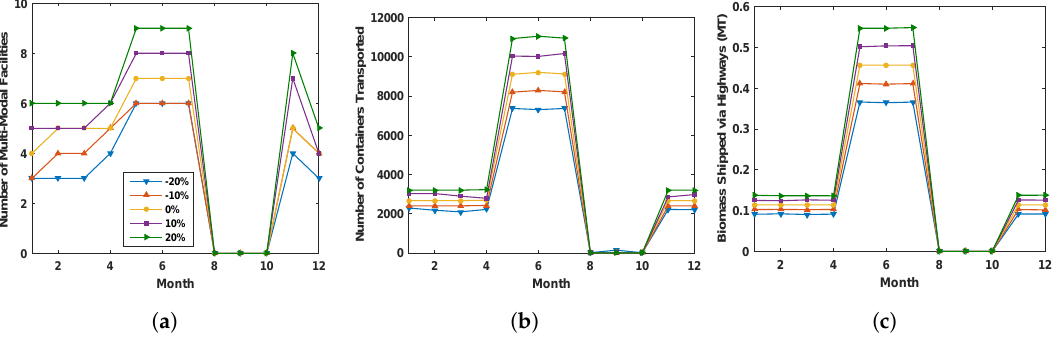
Figure 9. Impact of supply changes on system performance. ( a ) Multi-modal facilities; ( b ) Containers transported; ( c ) Biomass shipped via